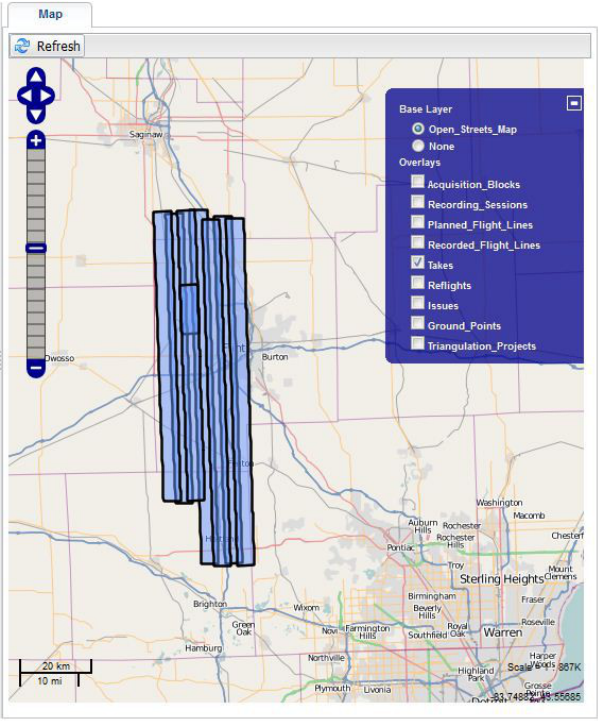
Figure 6: Footprints of ingested and geo-referenced flight